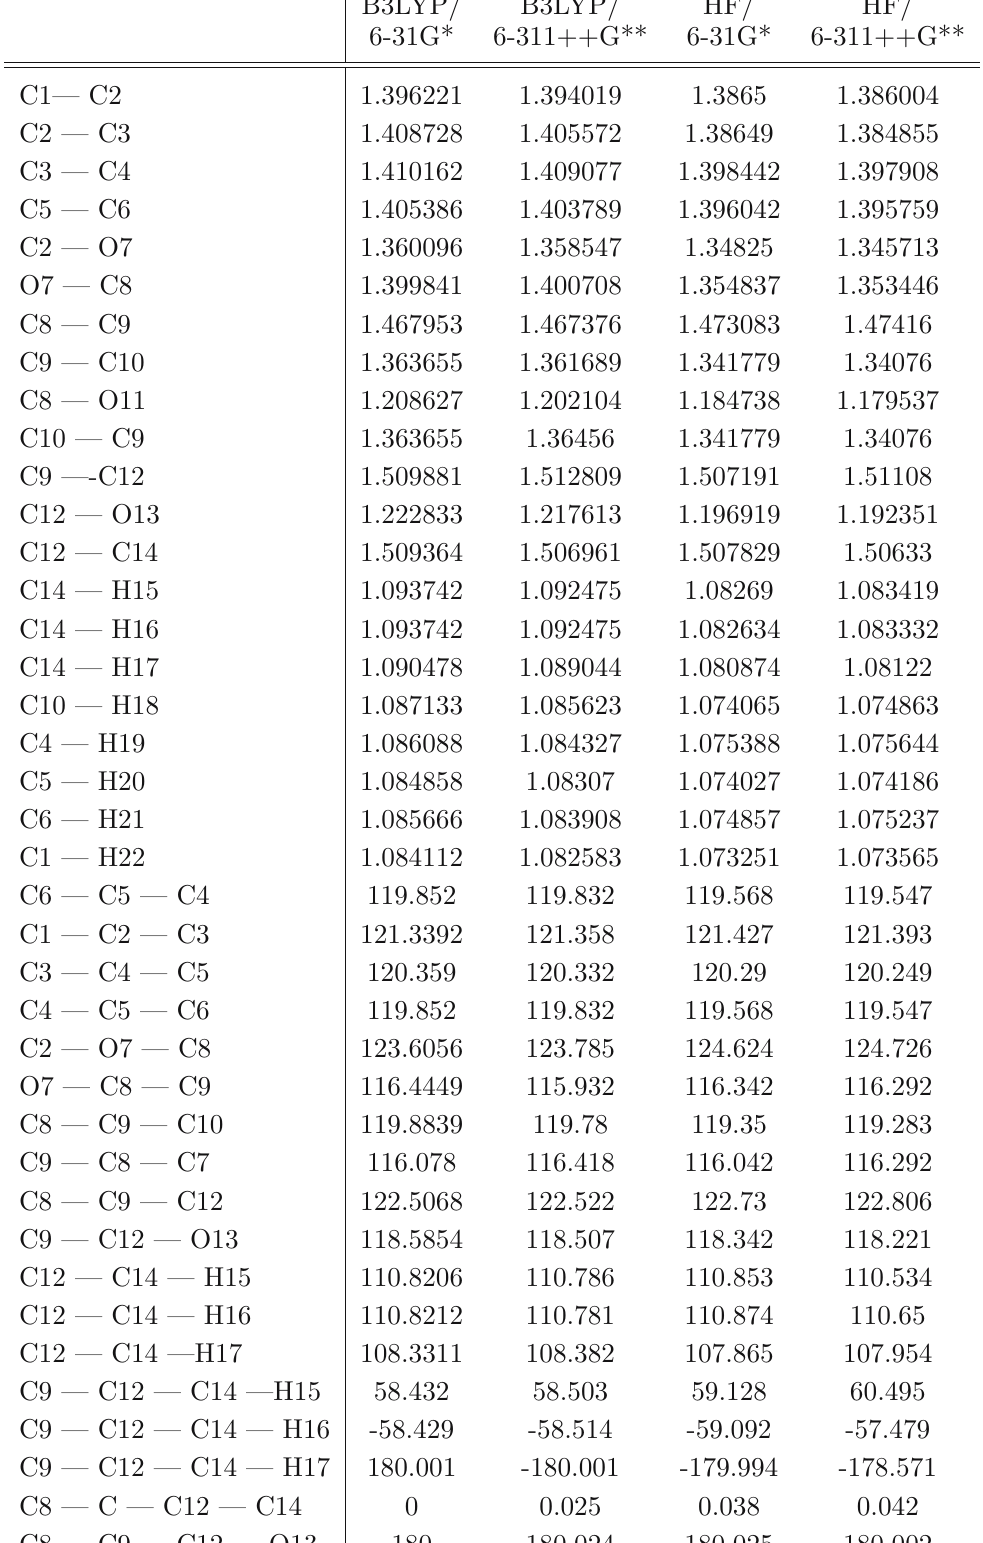
Table 2 Geometrical parameters of acetyl coumarin (s-cis) obtained by ab initio and B3LYP methods (distance in ˚ A, angles in